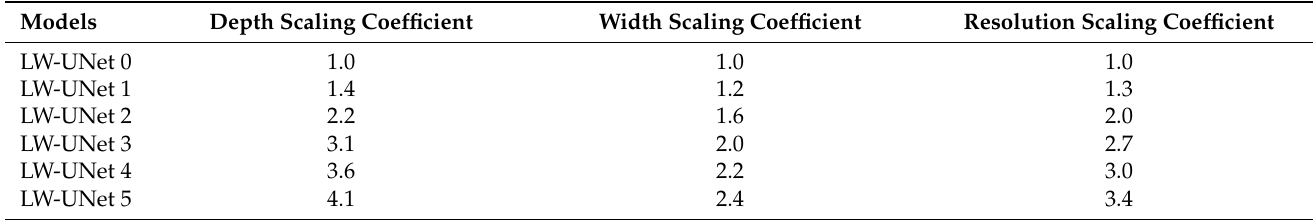
Table 1. The scaling coefficient of LW-UNet